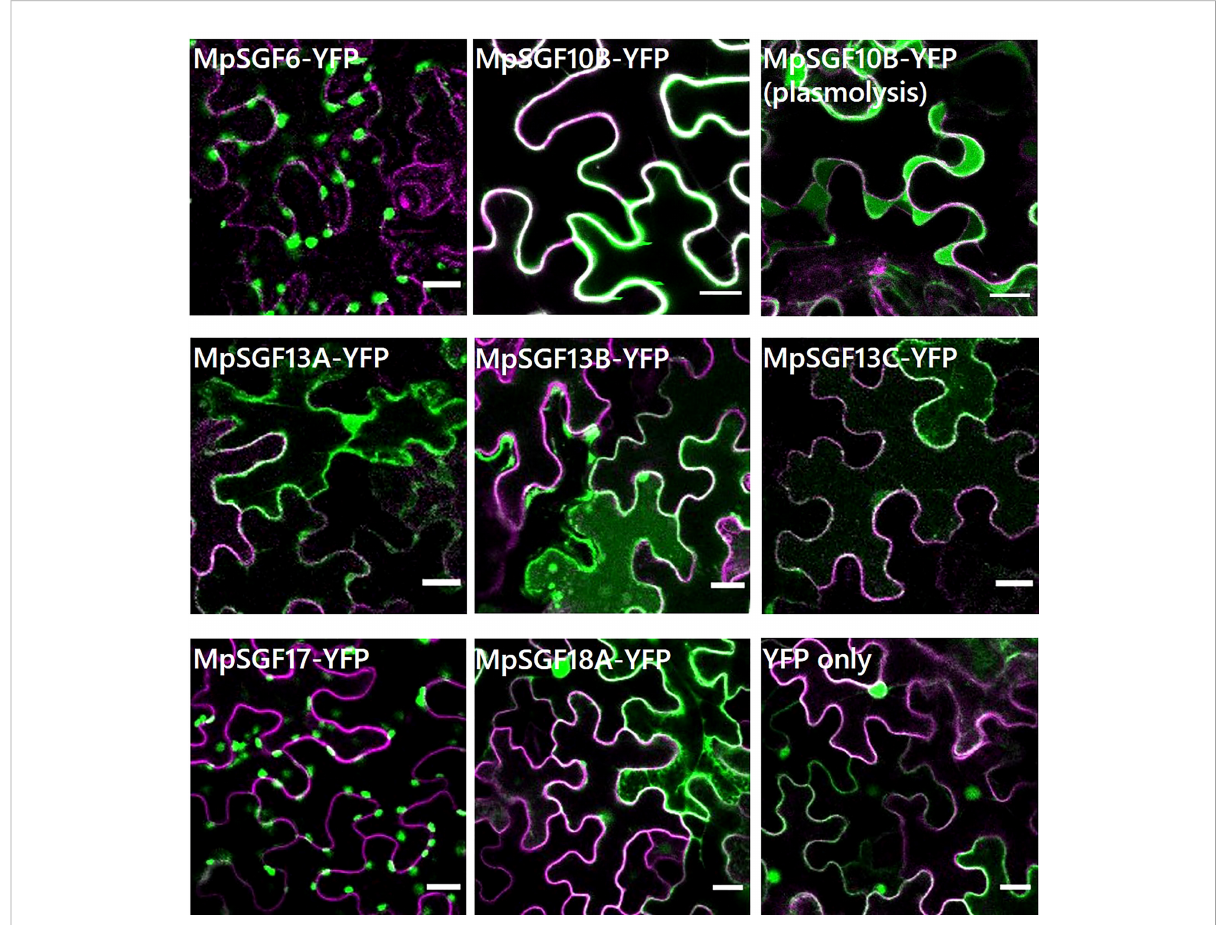
FIGURE 3 Subcellular localization of MpSGFs in N. benthamiana . Confocal fl uorescence microscopy images of MpSGF-YFP transiently expressed in N. benthamiana ; MpSGF6, MpSGF10B under control (water) and hypertonic conditions, MpSGF13A, MpSGF13B, MpSGF13C, MpSGF17, MpSGF18A, and YFP only. The plasma membrane, which was visualized by mRFP-LTI6b, and YFP were shown in magenta and green, respectively. Bars = 20